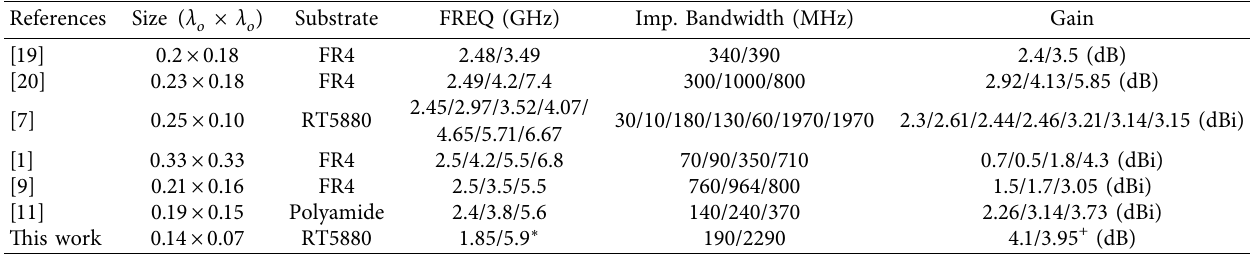
Table 3: Proposed OBS antenna and other works in the literature Comparative